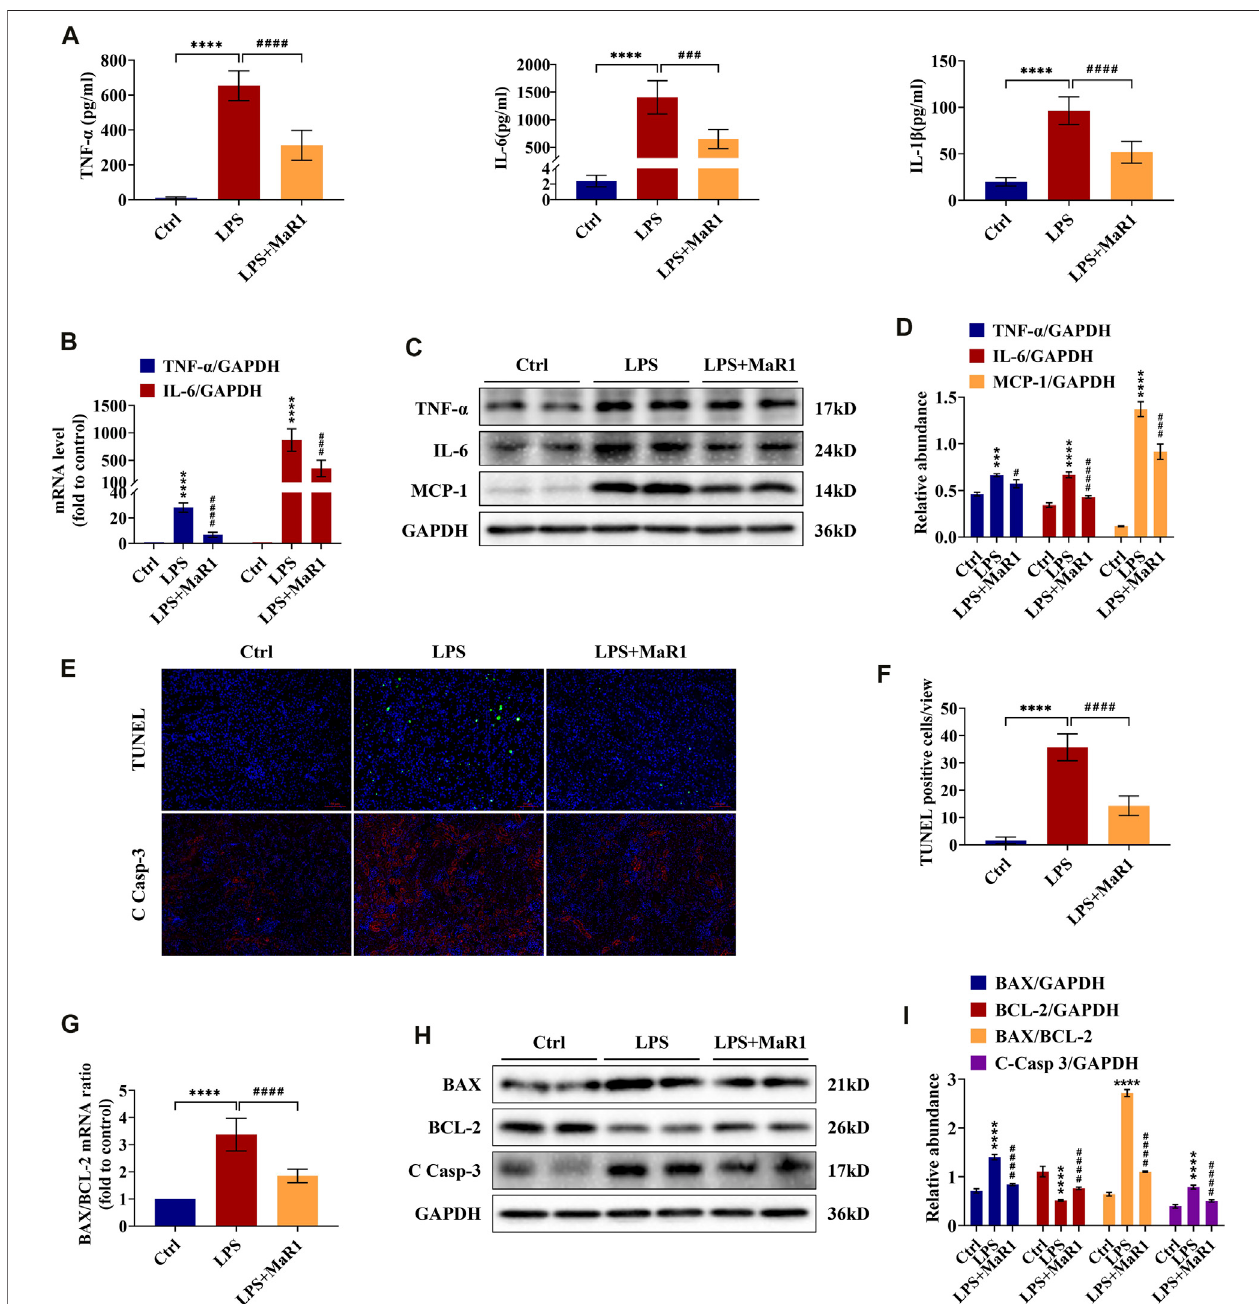
FIGURE 2 | MaR1 inhibited in fl ammation and renal cell apoptosis in lipopolysaccharide (LPS)-induced S-AKI mice. (A) The serum levels of TNF- α , IL-6, and IL-1 β weredeterminedusingassaykitsineach groupofmice. (B) Geneexpression ofTNF- α and IL-6inrenal tissueswasquantitatedusingqRT-PCR. (C) Theexpressionsof TNF- α , IL-6, and MCP-1 in renal tissues were analyzed using Western blot. (D) The protein levels of TNF- α , IL-6, and MCP-1 were quanti fi ed by densitometry and normalized with GAPDH. (E) TUNEL staining and immuno fl uorescence staining images of cleaved caspase-3 (C Casp-3) expression in renal sections were collected (scale bars (cid:2) 50 μ m). (F) TUNEL staining positive cells were counted in each group. (G) The gene expression ratio of BAX/BCL-2 in renal tissues was quantitated using qRT-PCR. (H) The expressions of BAX, BCL-2, and C Casp-3 in renal tissues were analyzed using Western blot. (I) The protein levels of BAX, BCL-2, and C Casp-3 were quanti fi ed by densitometry and normalized with GAPDH (time point: 12 h). Data are presented as mean ± SD, n (cid:2) 5. * p < 0.05, ** p < 0.01, *** p < 0.001, **** p < 0.0001 vs . control group; # p < 0.05, ## p < 0.01, ### p < 0.001, #### p < 0.0001 vs . LPS group.